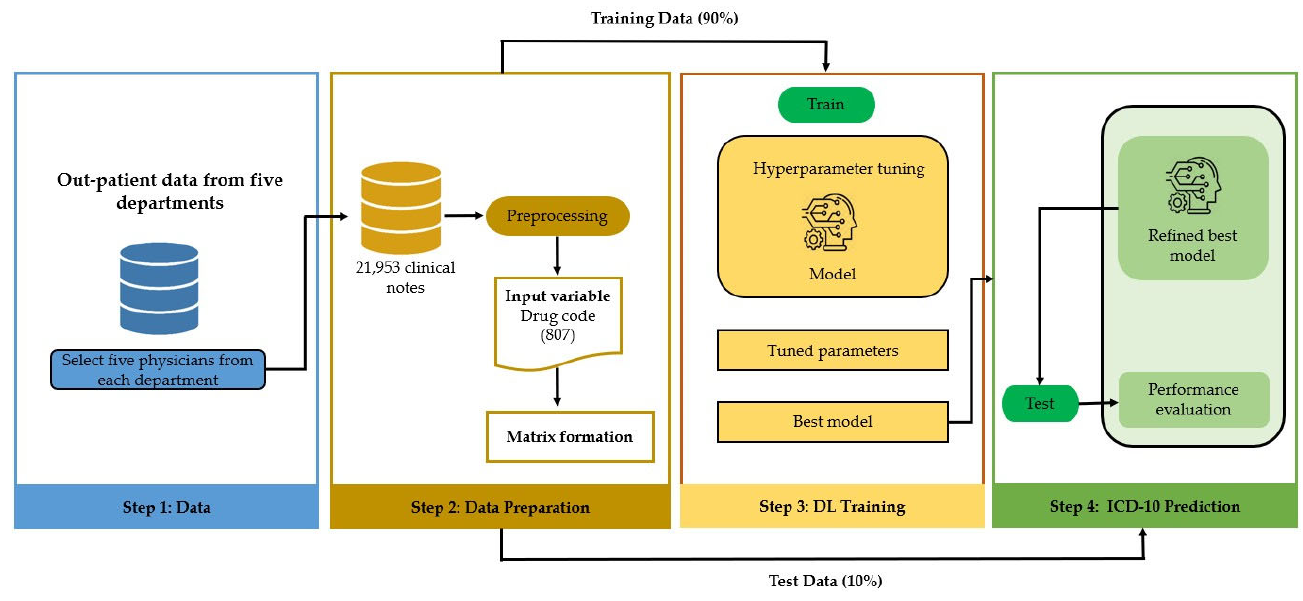
Figure 6. The overall process used in our study.